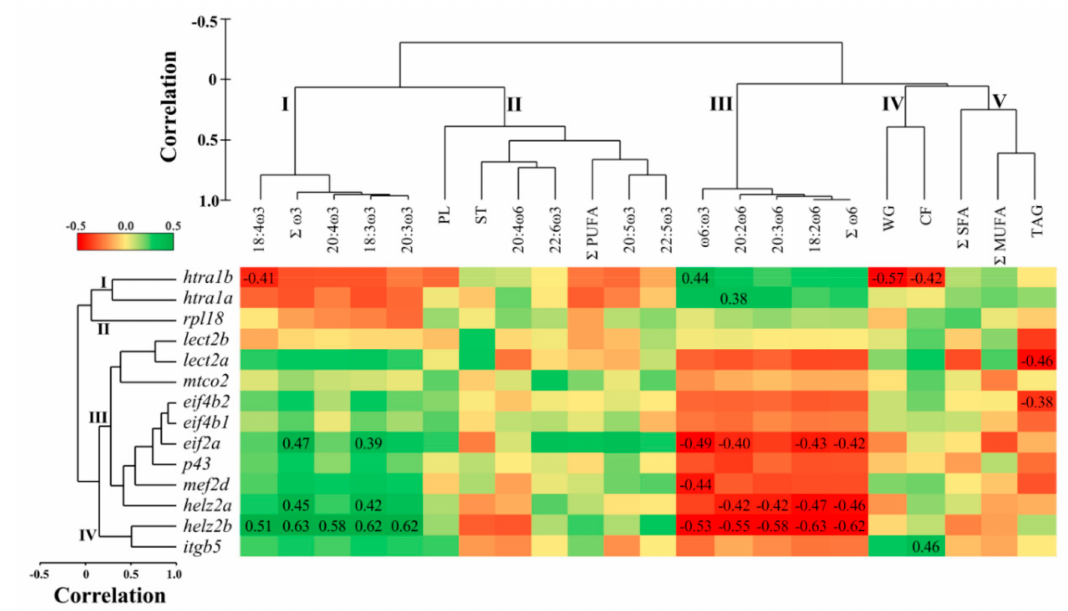
Figure 2. Pearson correlation matrix and hierarchical clustering of liver transcript expression (qPCR relative quantity values (RQ)), muscle lipid composition, and growth in Atlantic salmon fed diets with varying ω 6 to ω 3 fatty acid ratios. Correlation coefficients were described when correlations were statistically significant ( p < 0.05). Red signifies negative and green signifies positive relationships. Σ SFA, Σ MUFA, and Σ PUFA represent total saturated, monounsaturated and polyunsaturated fatty acids, respectively. 20:5 ω 3, 22:6 ω 3, and 20:4 ω 6 represent EPA, DHA, and ARA, respectively. TAG, ST and PL represent triacylglycerols, sterols, and phospholipids, respectively. WG and CF represent weight gain and condition factor,